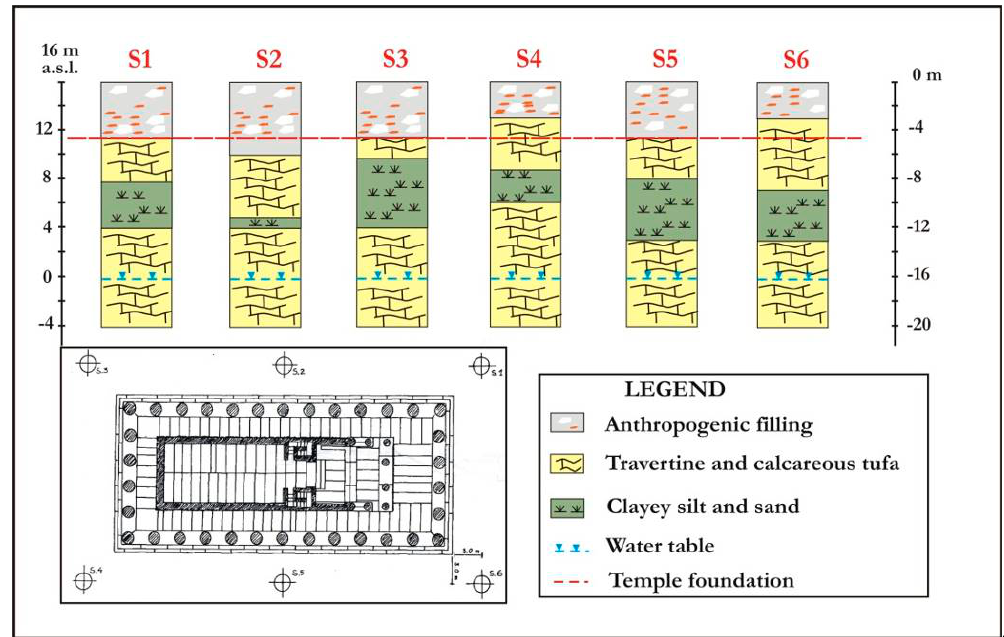
Figure 8. Schematic stratigraphic logs of the boreholes carried out close to the Temple of Athena, modified and redrawn by Pescatore and Viggiani [44].